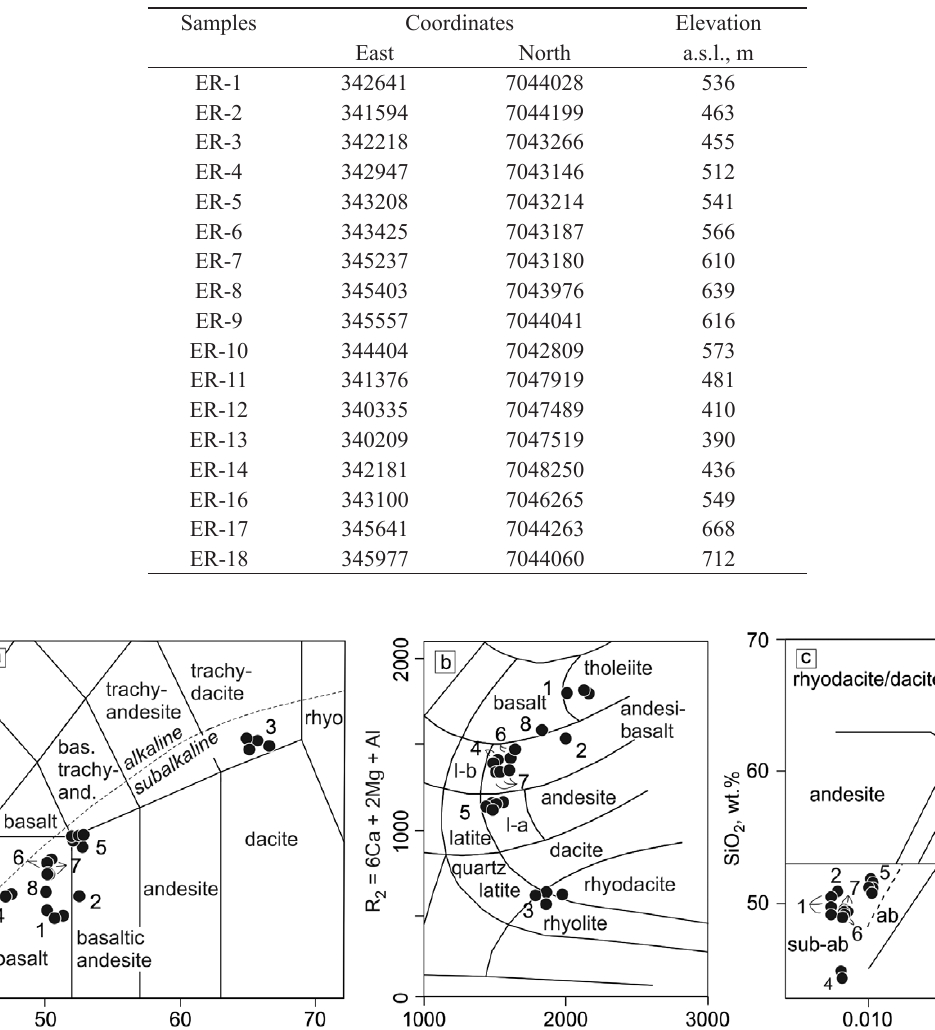
Location and elevation of analyzed samples.